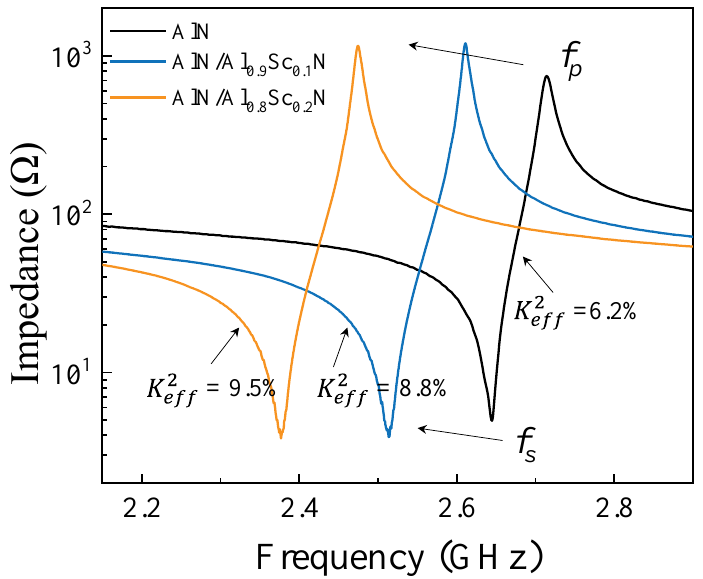
Figure 6. Tested impedance curves of FBARs with different piezoelectric materials : 1 μm -thick pure AlN, 1 μm -thick AlN/Al 0.9 Sc 0.1 N composite piezoelectric layer comprising 500 nm-thick AlN and 500 nm-thick Al 0.9 Sc 0.1 N, and 1 μm -thick AlN/Al 0.8 Sc 0.2 N composite piezoelectric layer comprising 500 nm-thick AlN and 500 nm-thick Al 0.8 Sc 0.2 N.